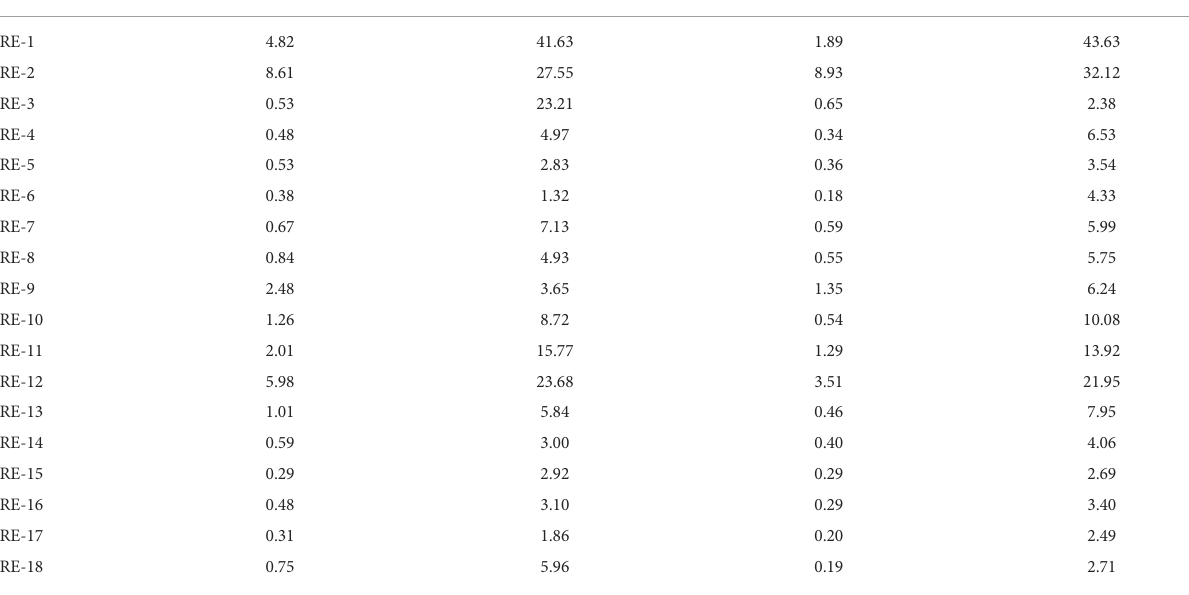
TABLE 1 MAEs of reconstructed tidal currents using part of the observations and the observed results in each experiment at the mooring